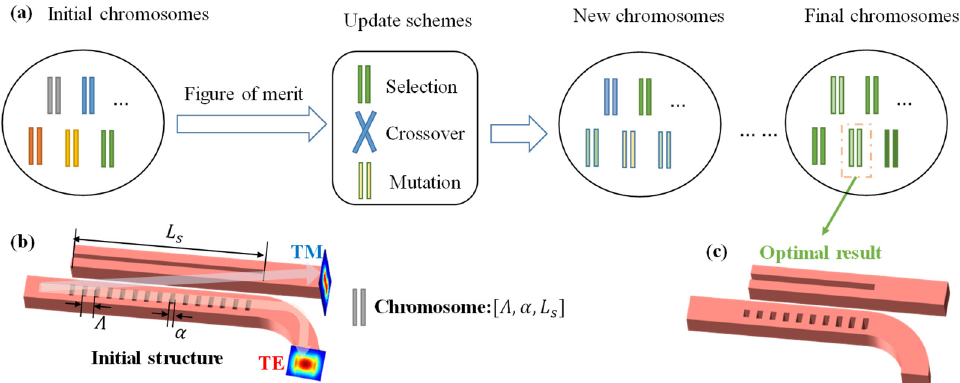
Figure 2. Schematic diagram of GA for the design of PBS based on directional coupler. ( a ) Operating principle of GA. ( b ) Initial structure of PBS and abstracted parameters. ( c ) Final structure of optimized PBS.